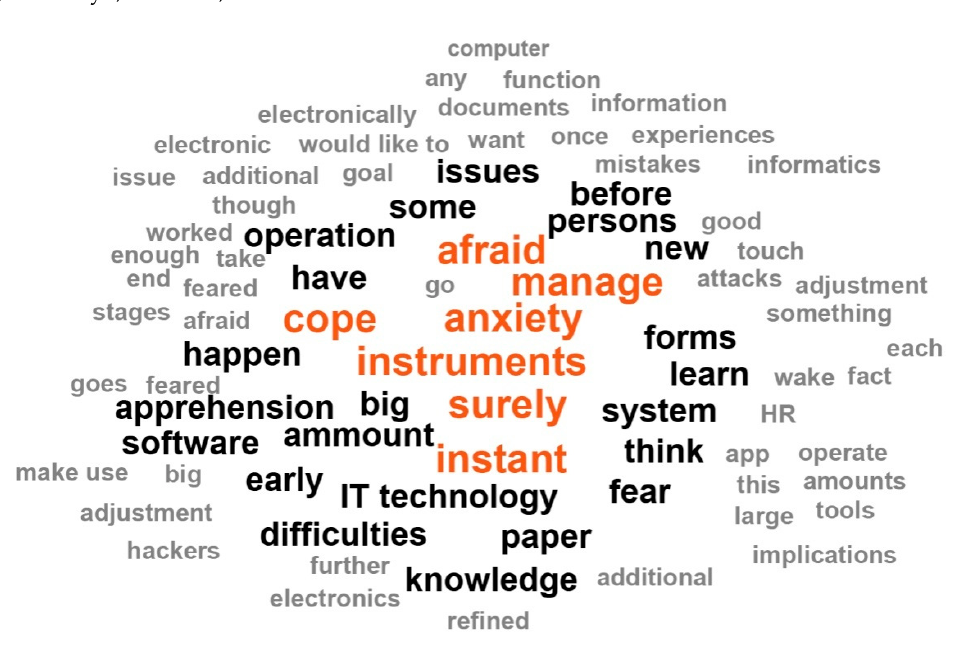
Figure 1. Word cloud: fears.